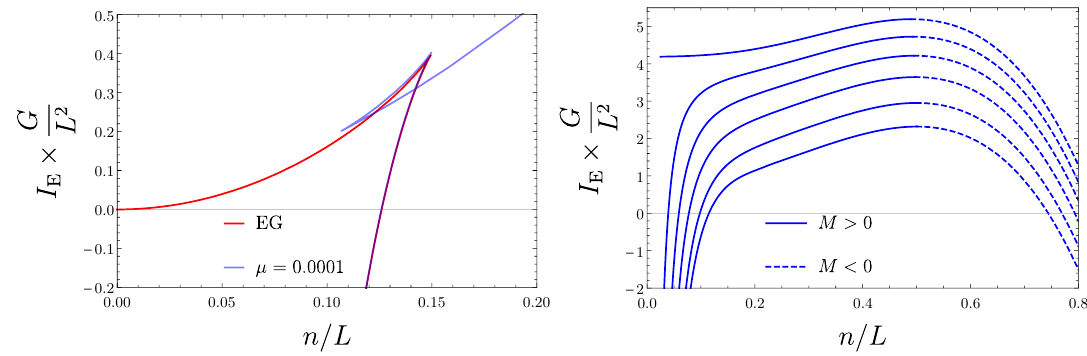
Figure 5 . Euclidean on-shell action for B = S 2 bolt solutions in ECG. In the left panel we compare the Einstein gravity result with the ECG one with (cid:22) = 0 : 0001, which contains three branches. For (cid:22) > 0 : 001126 there is only one branch, which is shown in the right panel for (cid:22) = 0 : 01 ; 8 = 270 ; 16 = 270 ; 24 = 270 ; 32 = 270 ; 4 = 27. The dashed lines correspond to M < 0, so they should be excluded. As we can see, when n ! 0 the free energy diverges to (cid:0)1 , except for the critical case (cid:22) = 4 = 27, which corresponds to the upper